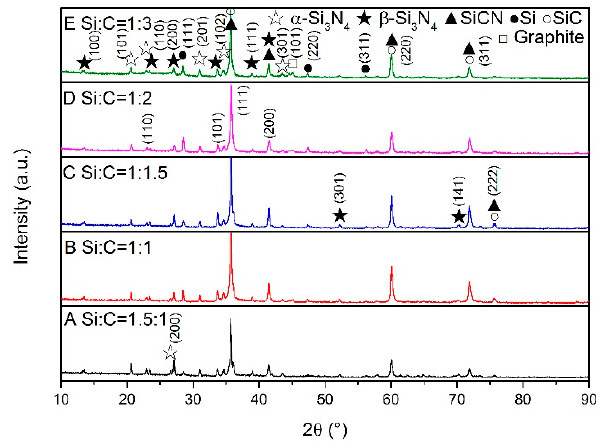
Figure 3. XRD patterns of samples with different Si/C ratios synthesized at 1550 °C.